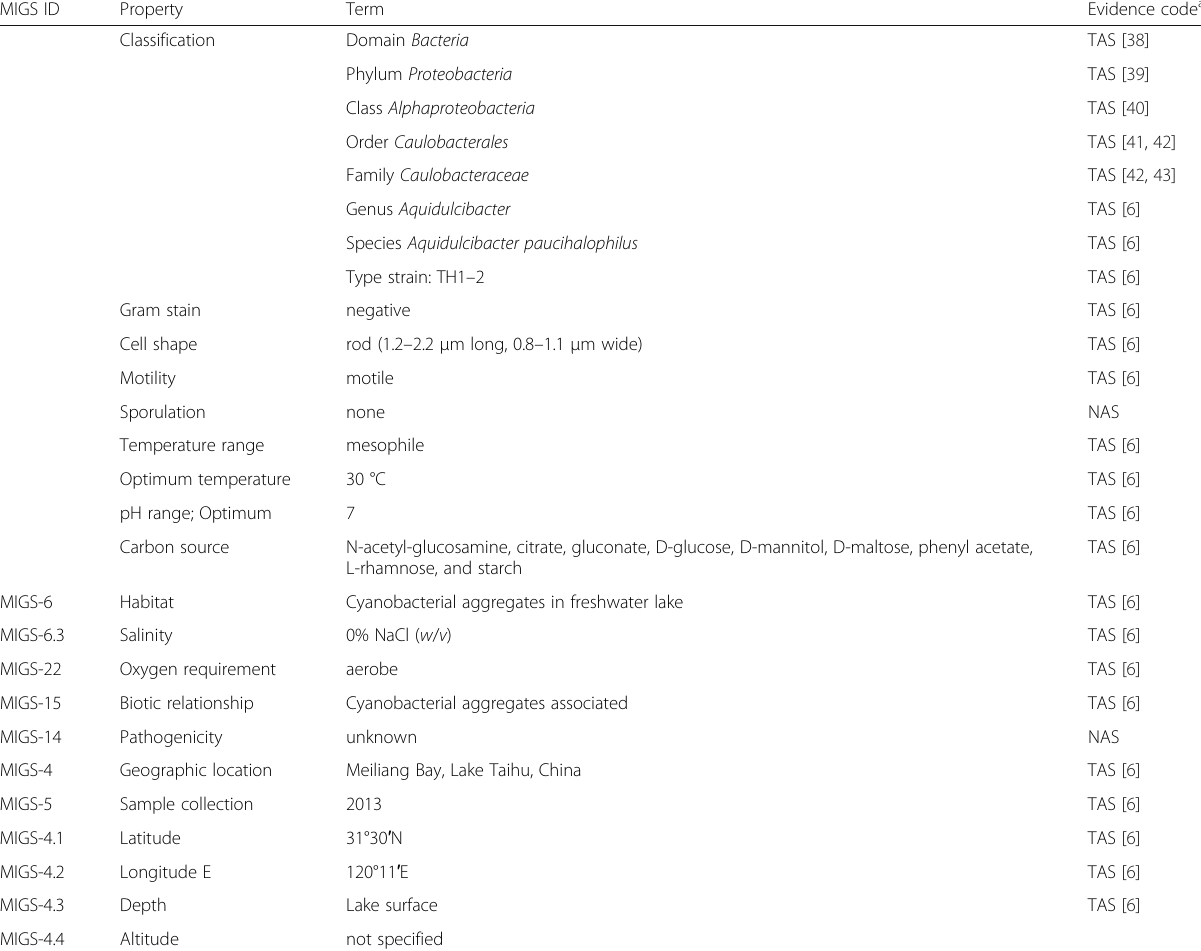
Table 1 Classification and general features of A. paucihalophilus strain TH1 – 2 T according to the MIGS recommendations